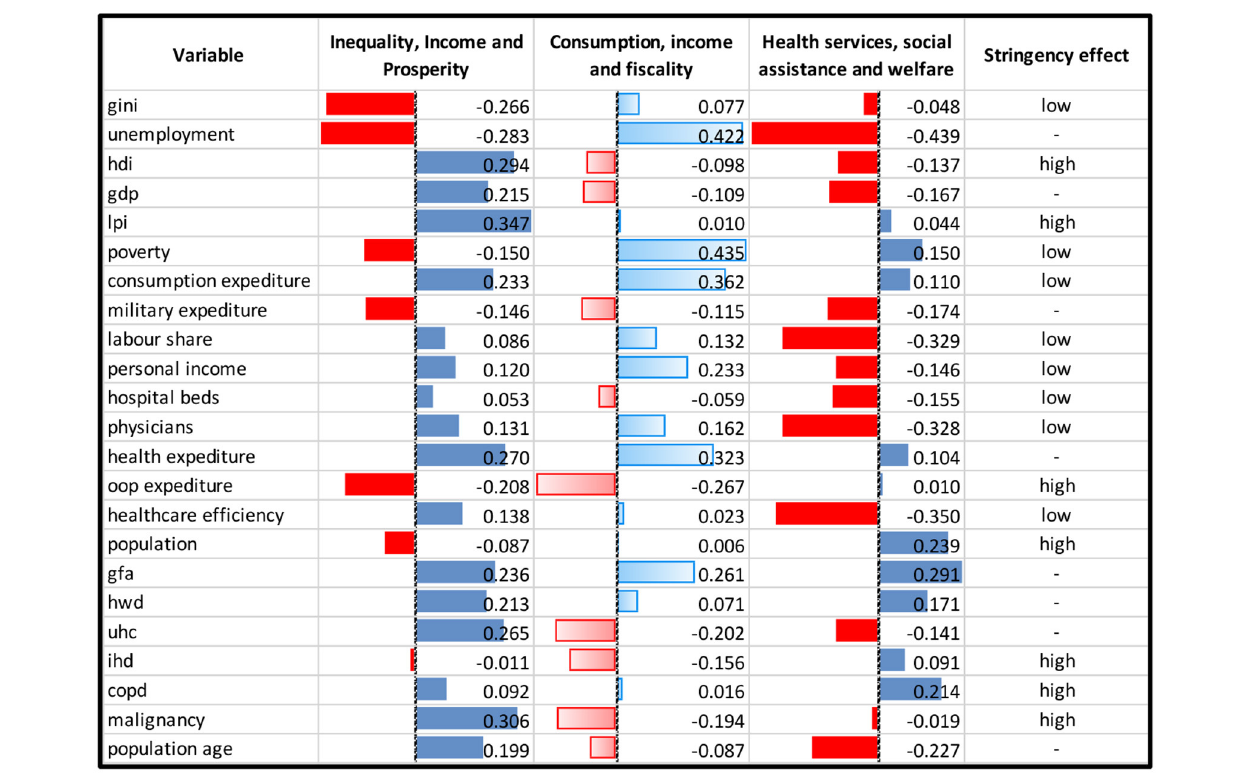
FIGURE 2 | Observed c ontribution on components obtained by